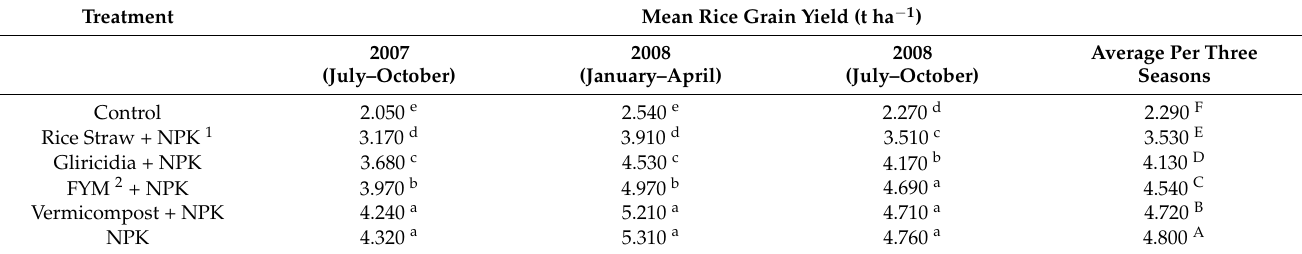
Table 4. Mean rice grain yield (t ha − 1 ) for each treatment per season and the average of the three seasons.